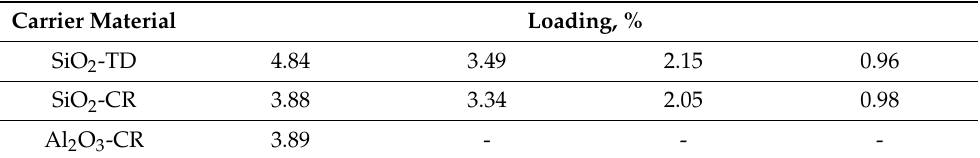
Table 1. Catalysts prepared with different Ru loading (% w / w , obtained by ICP-EOS analyses) using Ru 3 (CO) 12 and subsequent high-temperature decomposition (marked with TD) and deposition- precipitation followed by chemical reduction using RuCl 3 as a precursor (marked with